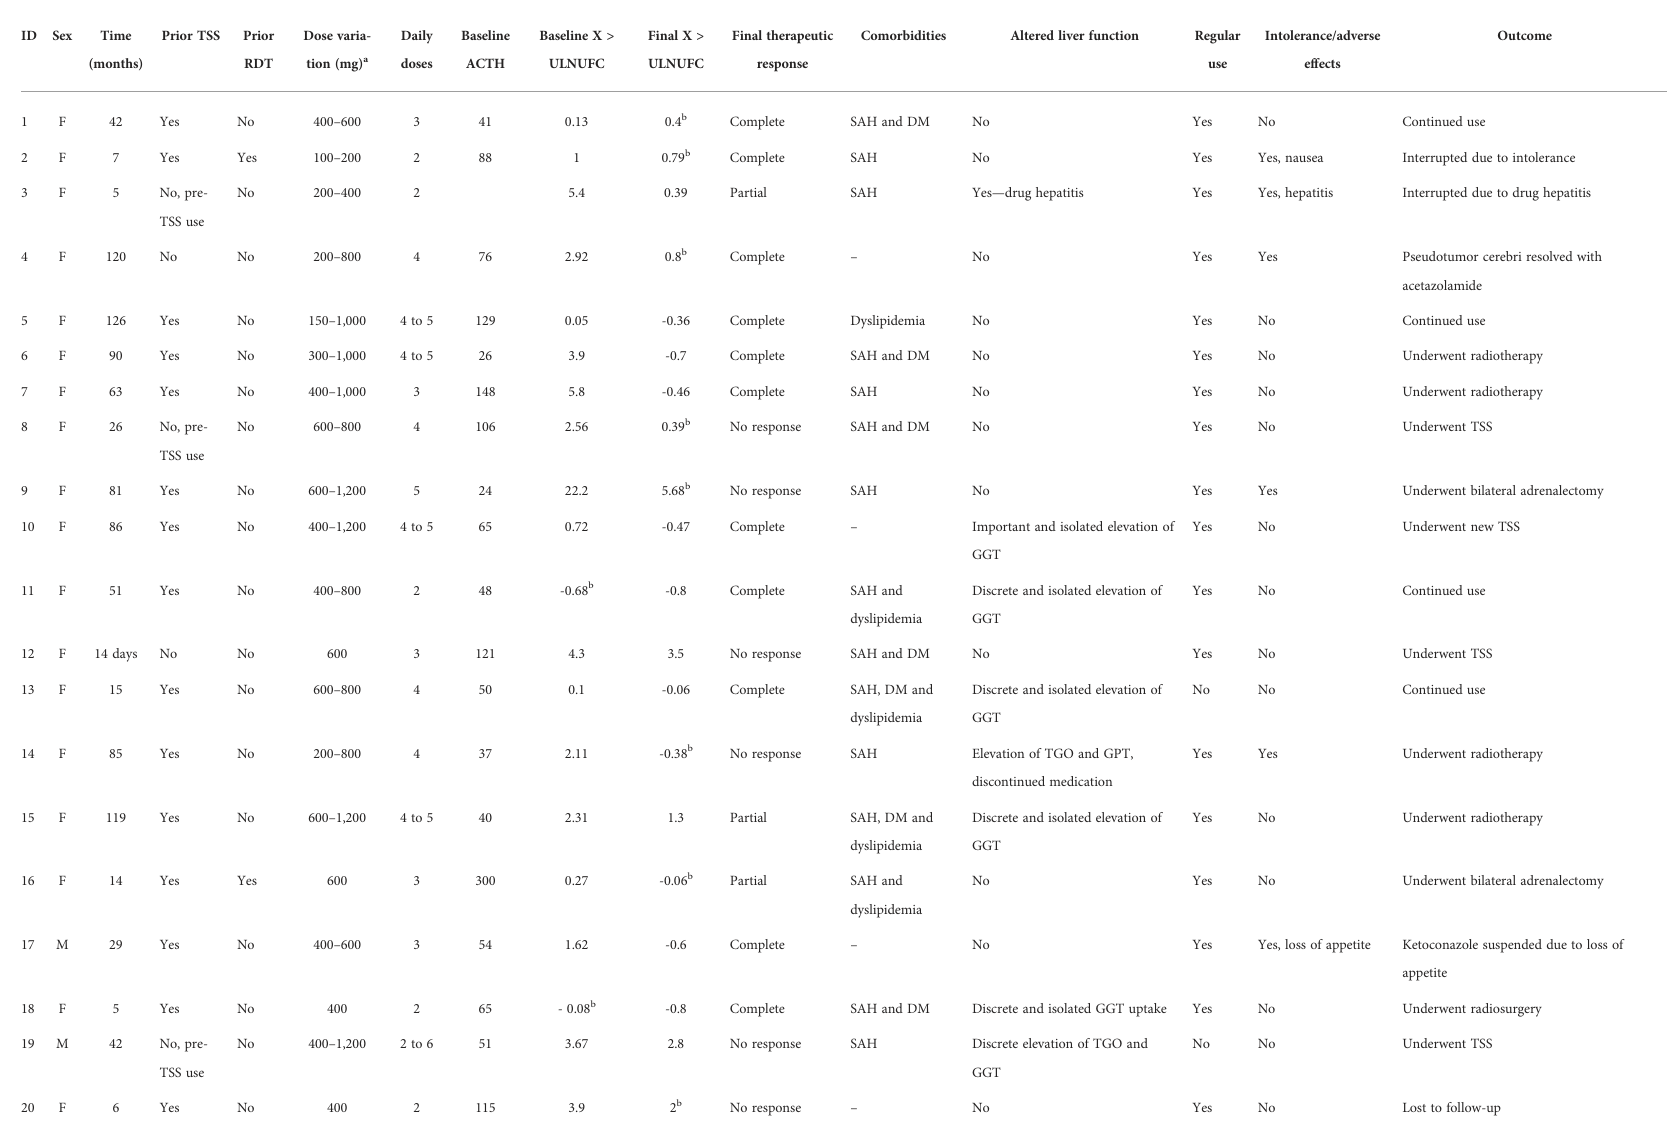
TABLE 2 Individual